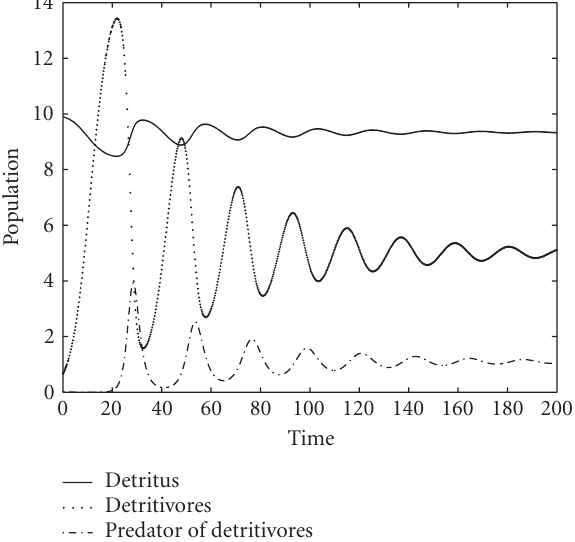
Figure 6.1. Solution of (5.1) with T 1 = 2 . 1 and T 2 = . 7, other parameters are same as described in Section 5.